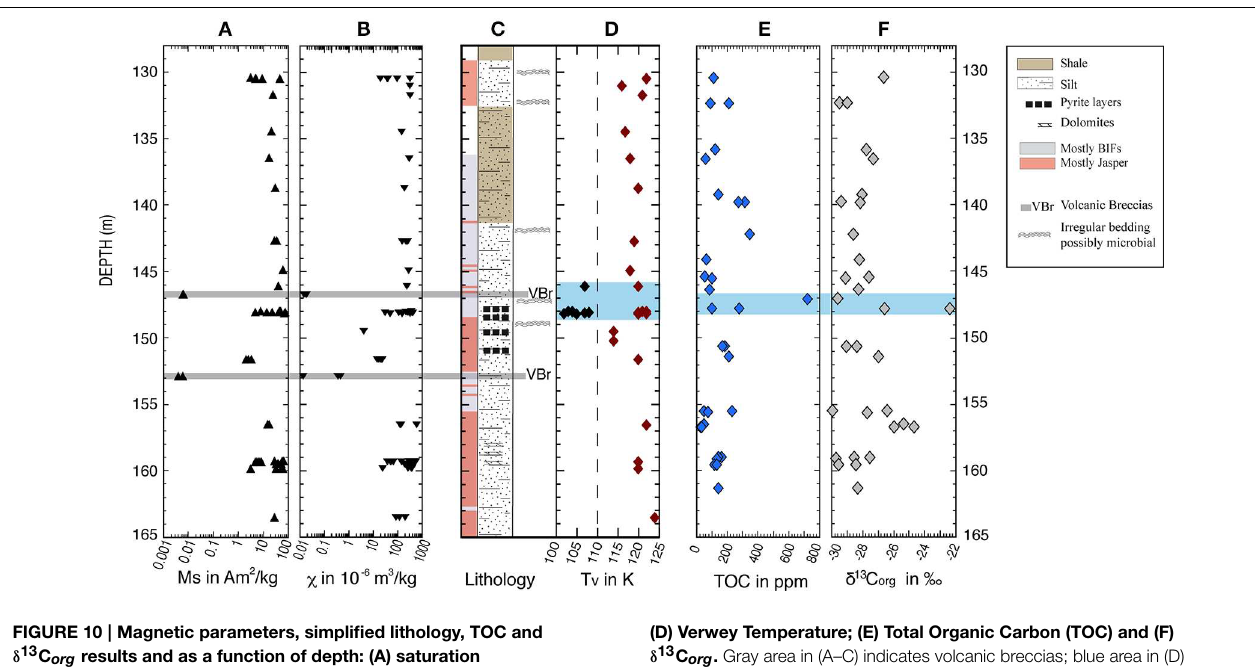
FIGURE 10 | Magnetic parameters, simplified lithology, TOC and δ 13 C org results and as a function of depth: (A) saturation magnetization Ms; (B) Mass normalized susceptibility; (C) lithology;